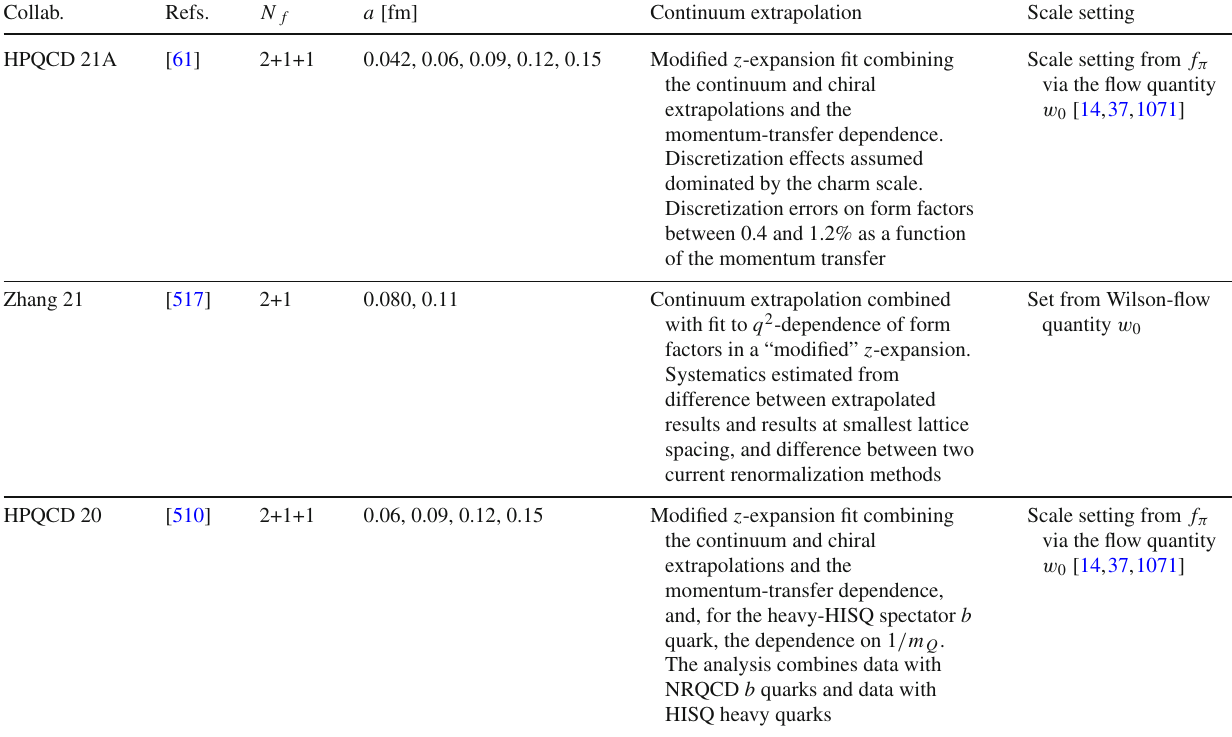
Table 135 Continuum extrapolations/estimation of lattice artifacts in N f = 2 + 1 + 1 determinations of form factors for semileptonic decays of charmed hadrons Collab.